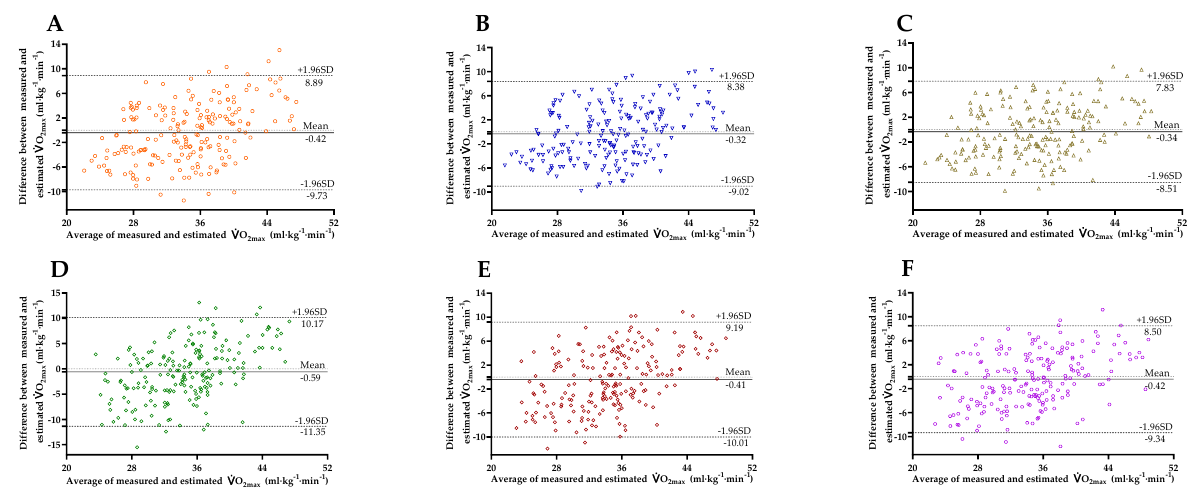
. • VO 2max obtained from PBF O 2max obtained from PBF